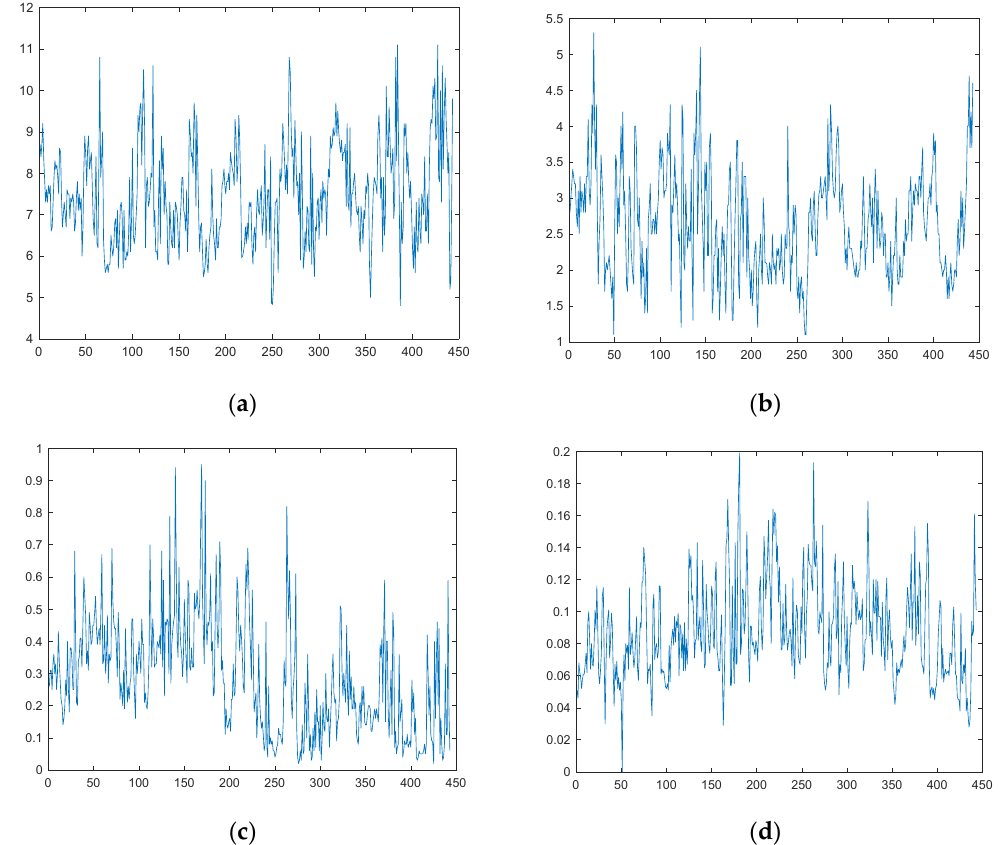
Figure 2. The image of dataset. ( a ) Dissolved oxygen (DO); ( b ) CODMn; ( c ) NH 3 ‐ N; ( d ) Total phosphorus (TP).